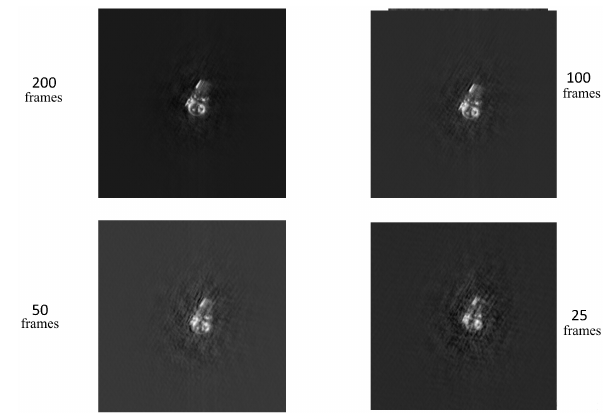
Figure 10. Restored images (point-spread functions– star №1)